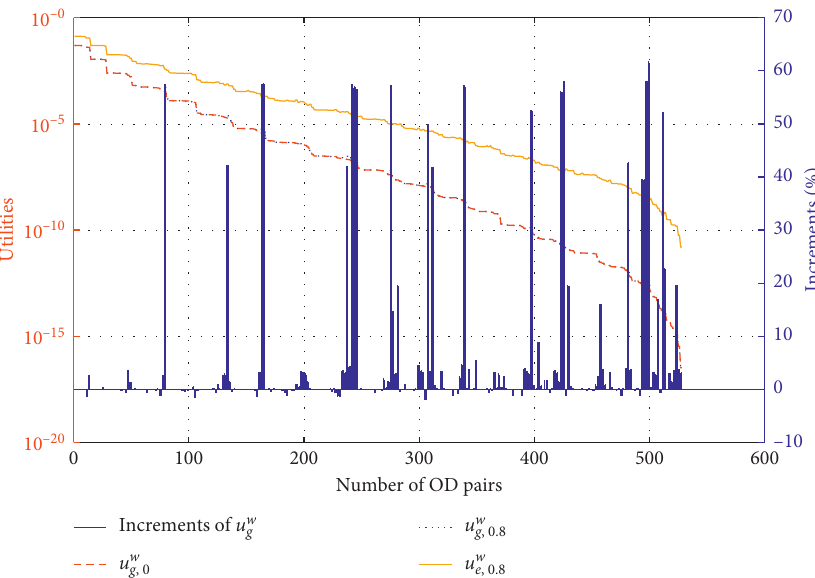
Figure 3: Utilities of 528 OD pairs of Sioux-Falls network with/without